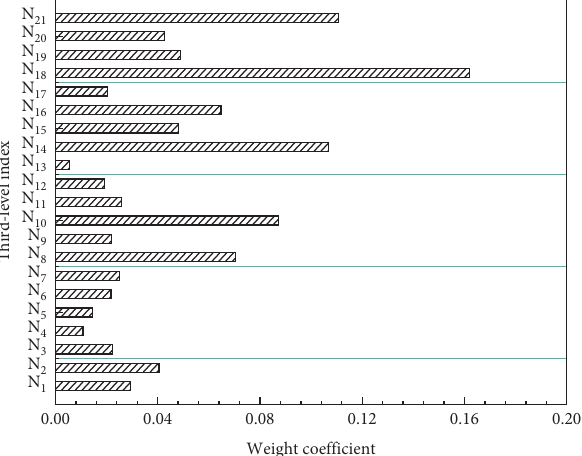
Figure 4: The weight coefficient of tertiary layer index on the assessment of college E&I education